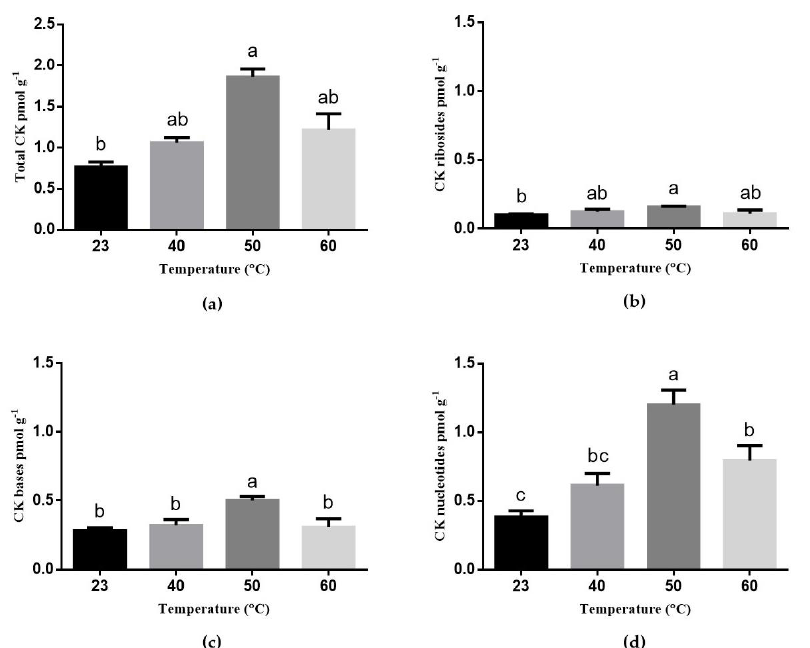
Figure 5. Effect of different temperatures (23 °C, 9 weeks; 40 ° C, 4 h; 50 °C, 30 min; 60 °C, 5 min) at Figure 5. E ff ect of di ff erent temperatures (23 ◦ C, 9 weeks; 40 ◦ C, 4 h; 50 ◦ C, 30 min; 60 ◦ C, 5 min) at endogenous concentration (pmol g −1 FW ± SE) of isoprenoids CKs ( a ) Total CKs; ( b ) CK ribosides; ( c ) endogenous concentration (pmol g − 1 FW ± SE) of isoprenoids CKs ( a ) Total CKs; ( b ) CK ribosides; CK bases; ( d ) CK nucleotides. ( c ) CK bases; ( d ) CK